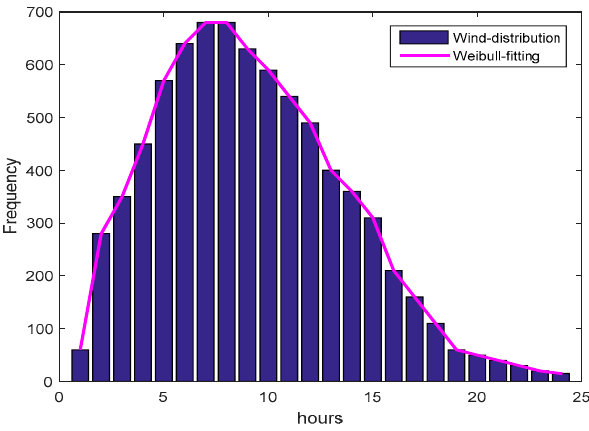
Figure 2. Frequency analysis-based wind speed (k=3, c = 6).